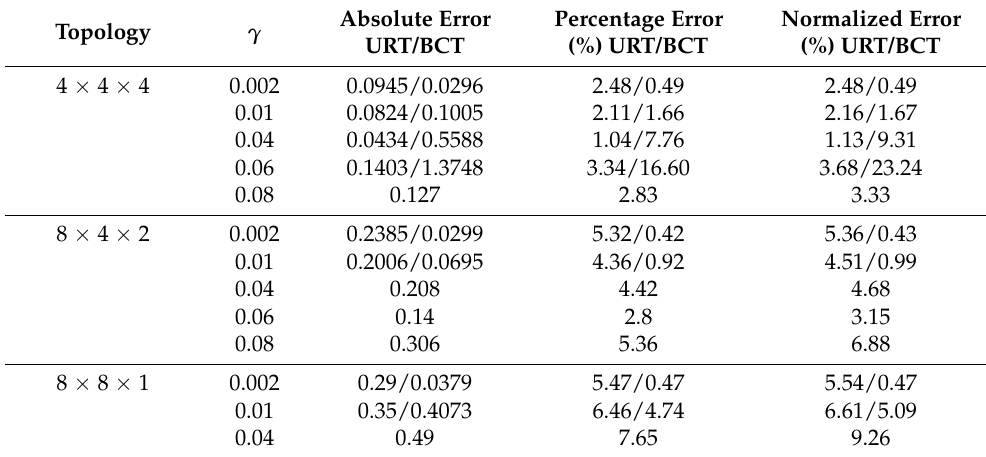
Figure 12. Percentage error vs. injection rate comparison between the proposed and the average distance model for 4 × 4 × 4 topology and bit-complement traffic. Table 1. Proposed model vs.